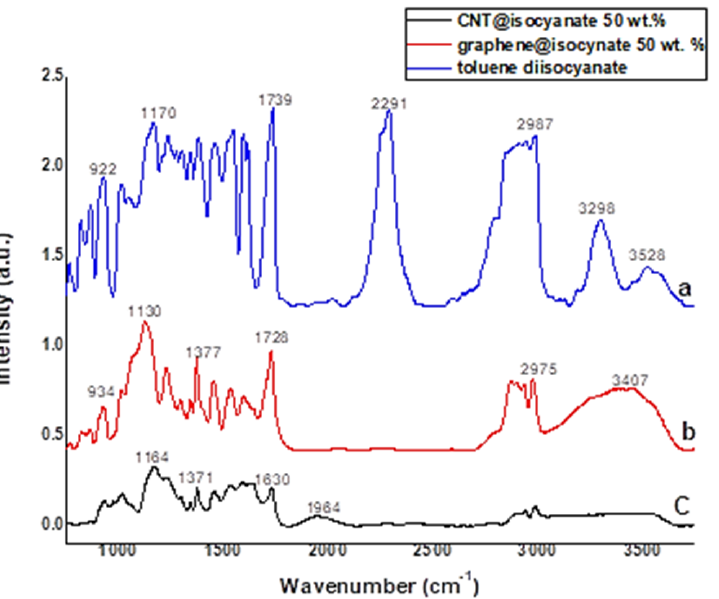
Figure 2. IRRA spectra ( a ) toluene di-isocyanate without doping on steel surface ( b ) GO@isocyanate 50 wt.% ( c ) FCNT@isocyanate 50 wt.%.